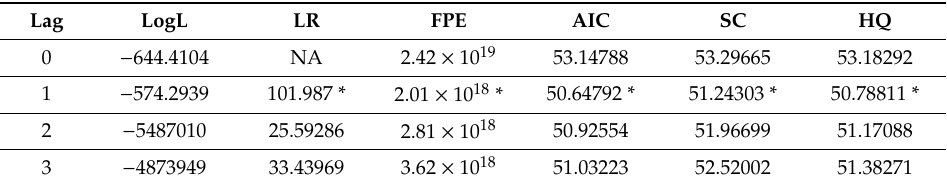
Table 5. Selection of lag length.